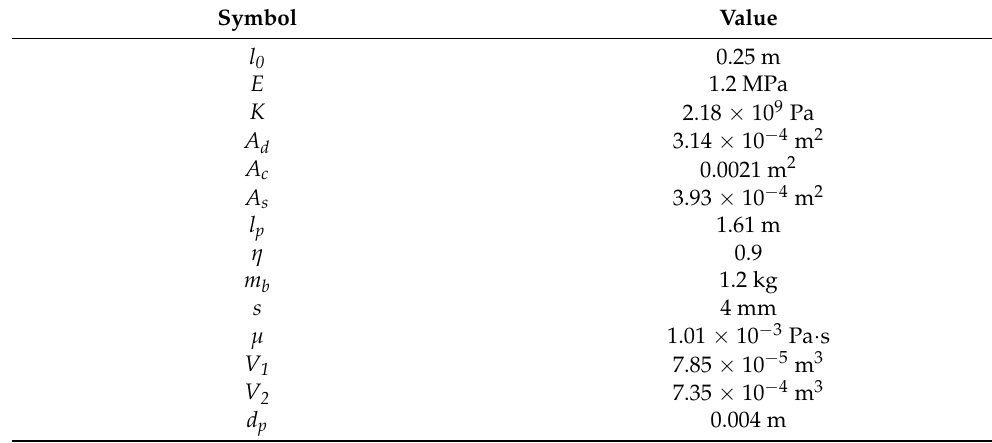
Table 1. Relevant